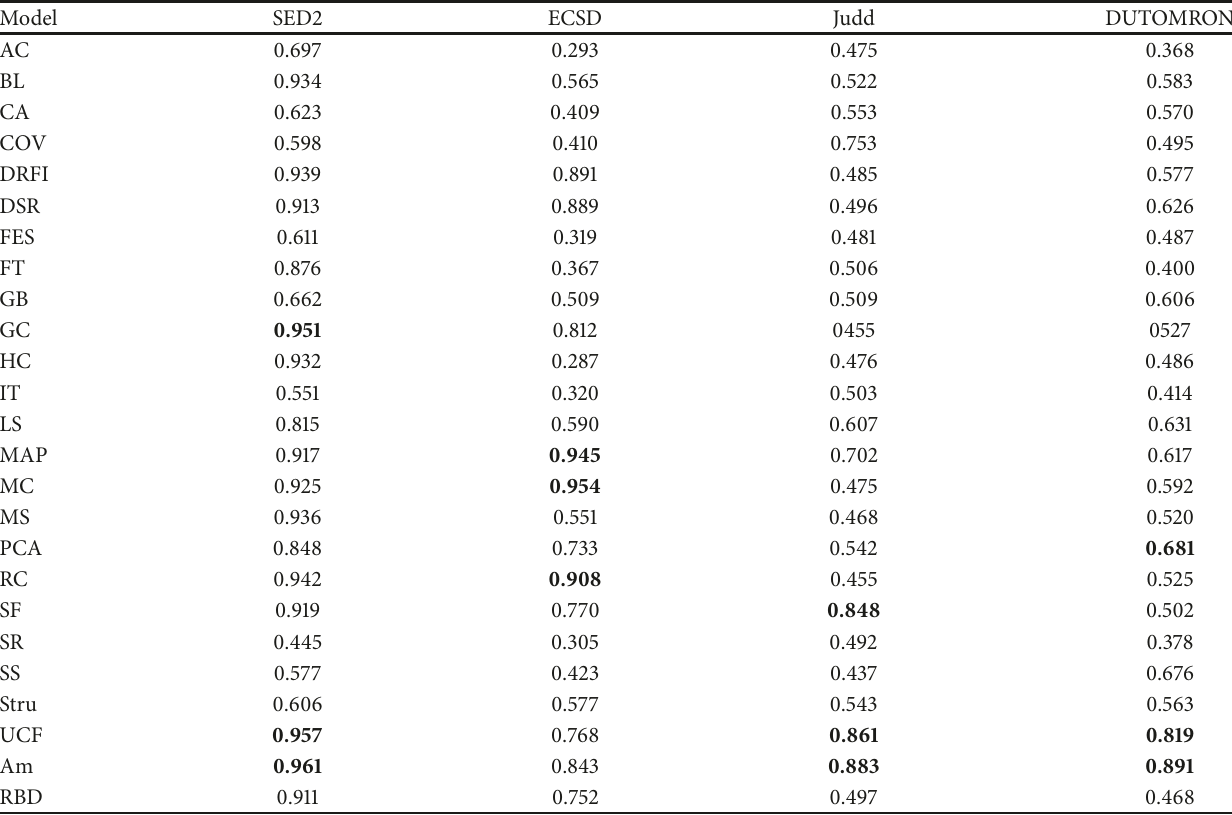
Table 3: S -measure score (larger is better; the top three models are highlighted in